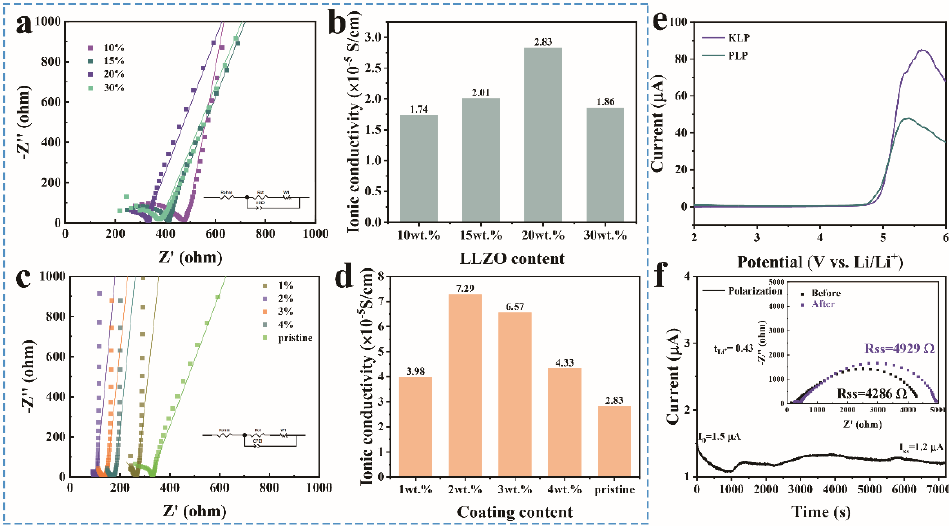
Figure 3. ( a ) Nyquist plots of PLP with different P − LLZO filler contents; ( b ) Room temperature calculated ionic conductivity of PLP with different filler ratios; ( c ) Nyquist plots of KLP coated with different coupling agent ratio; ( d ) Room temperature calculated ionic conductivity of KLP coated with different coupling agent ratio; ( e ) Linear sweep voltammetry (LSV) curves of KLP and PLP; ( f ) KLP lithium-ion transfer number (The inset is the impedance before and after polarization). In addition, the Li-ion transference number (T Li+ ) is also a critical factor of composite electrolytes. A high T Li+ is beneficial for SSEs to enable smooth Li + flux and suppress Li dendrites growth [35]. Generally, polymer-based electrolytes show a low T Li + due to